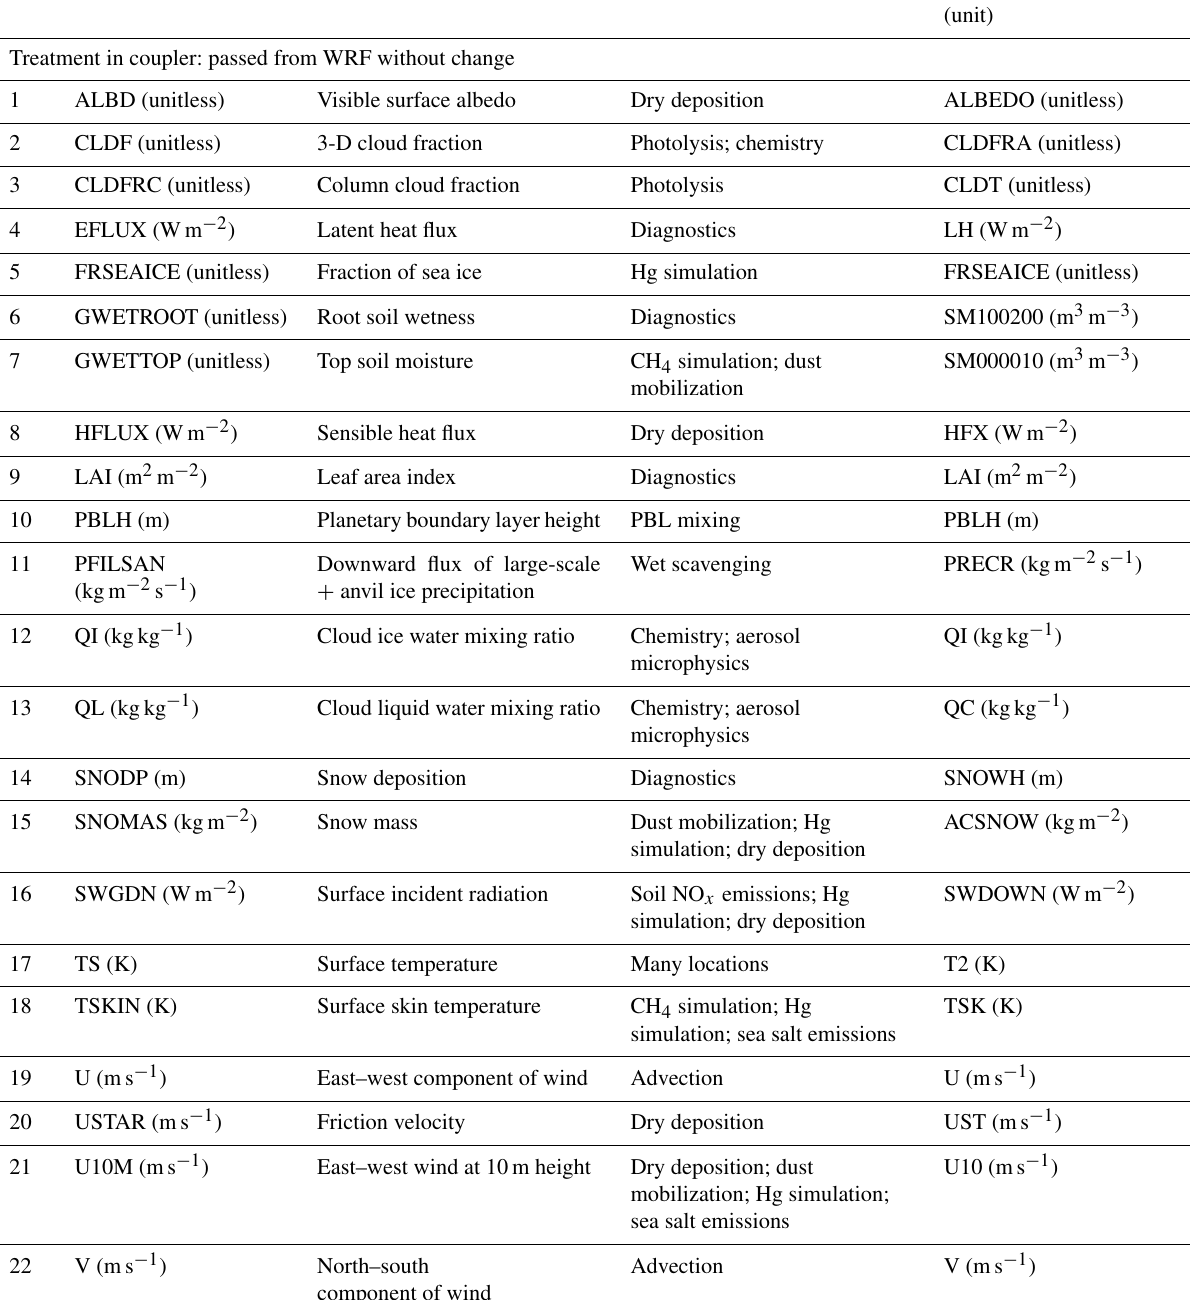
Passed or calculated from which variable(s) in